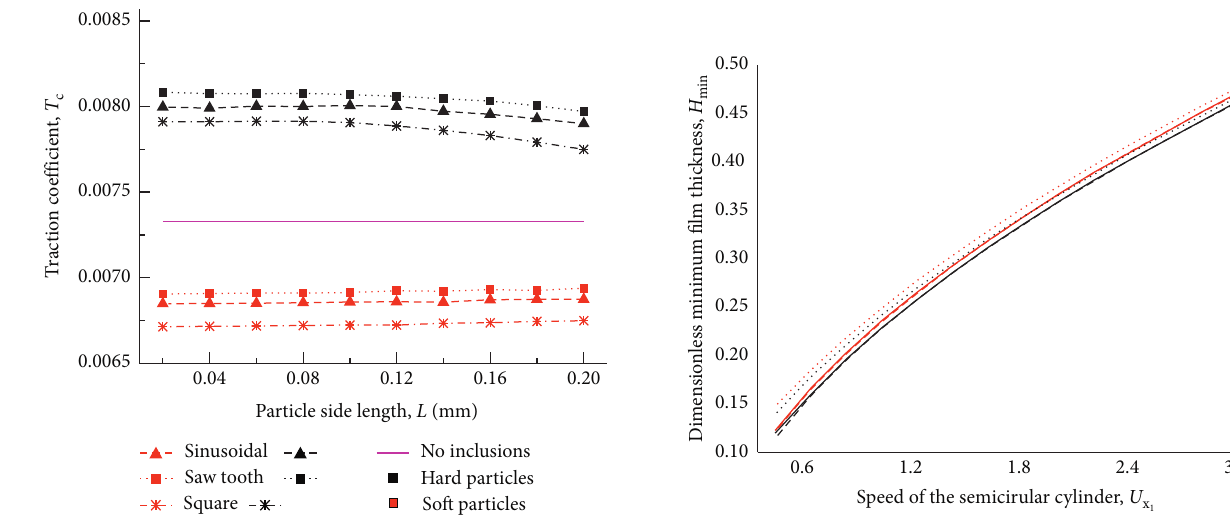
Figure 13: Effects of particle side length on the traction coefficient.